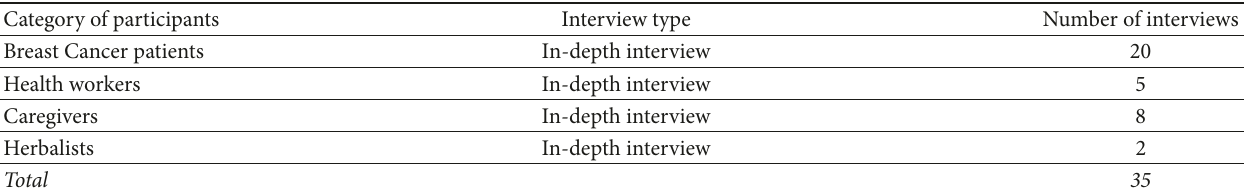
Table 1: Breakdown of interviews conducted.